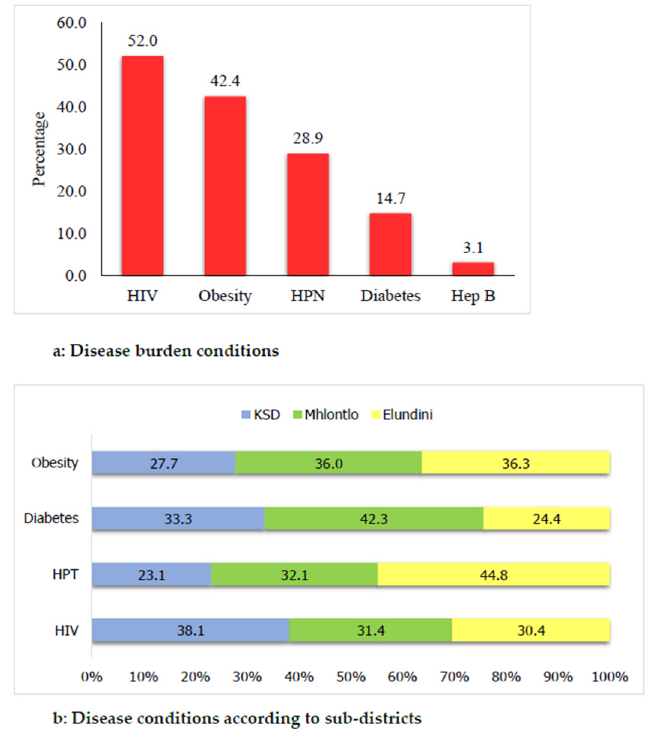
Figure 5. Prevalence of identified disease conditions Table 2. Identified disease